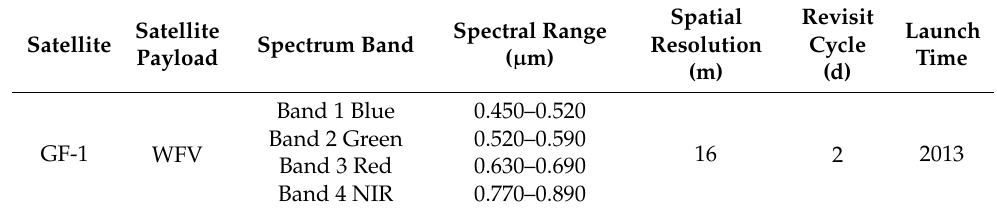
Table 1. GF-1 WFV load technical index.